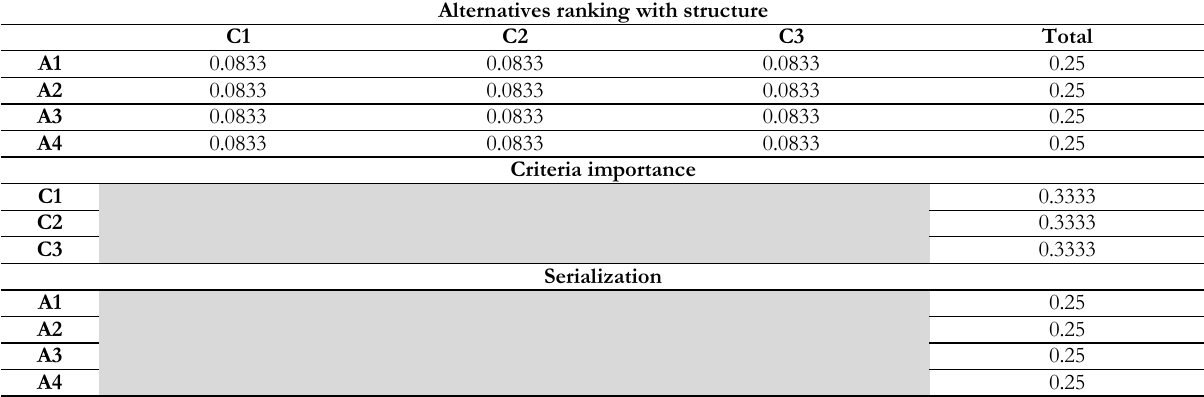
Figure 10. Dashboard Table 1. Applying AHP method to scenario